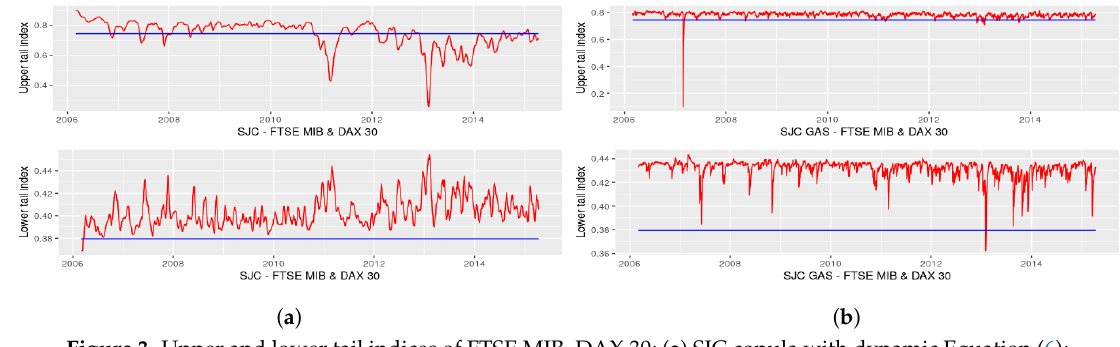
Figure 3. Upper and lower tail indices of FTSE MIB–DAX 30; ( a ) SJC copula with dynamic Equation (6); ( b ) SJC copula with dynamic Equation (7).